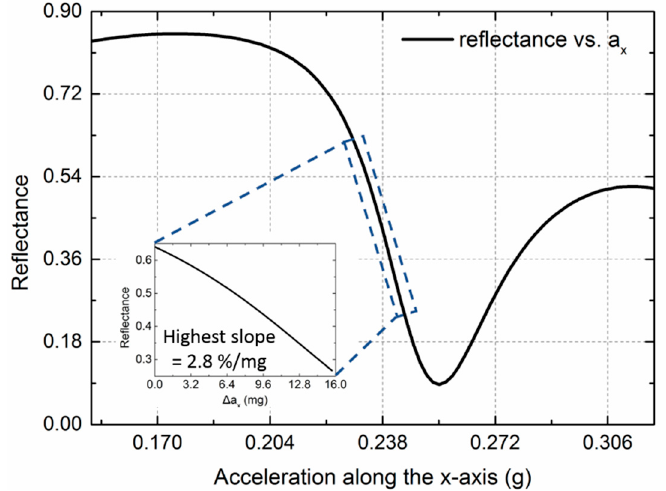
Figure 13. Curve of the zeroth reflectance as a function of the acceleration along the x -axis. Inset: enlarged view of the linear region, which indicates the highest slope can be as high as 2.8%/m g